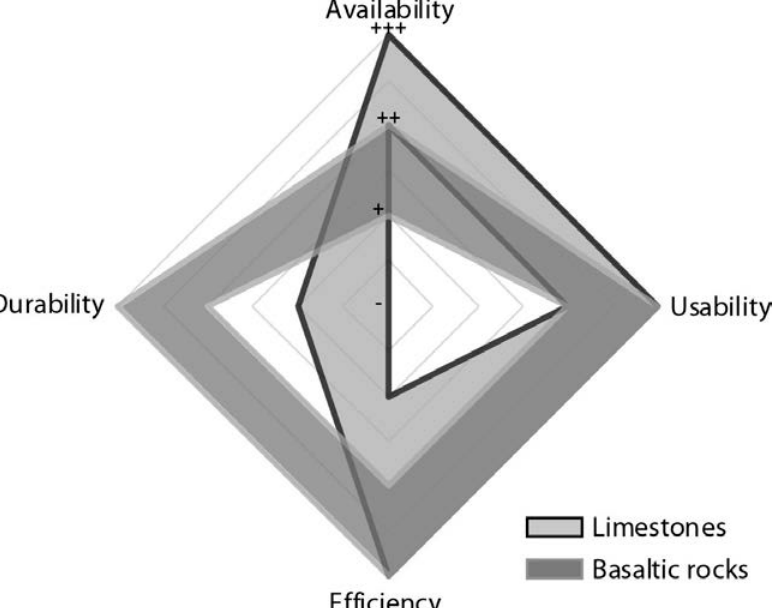
Figure 11. Diagram indicating the advantages (+: very few advantages, ++: clear advantages, and +++: strong clear advantages) and clear disadvantages (-) of limestone millstones compared to volcanic rocks among the Reims quern assemblage